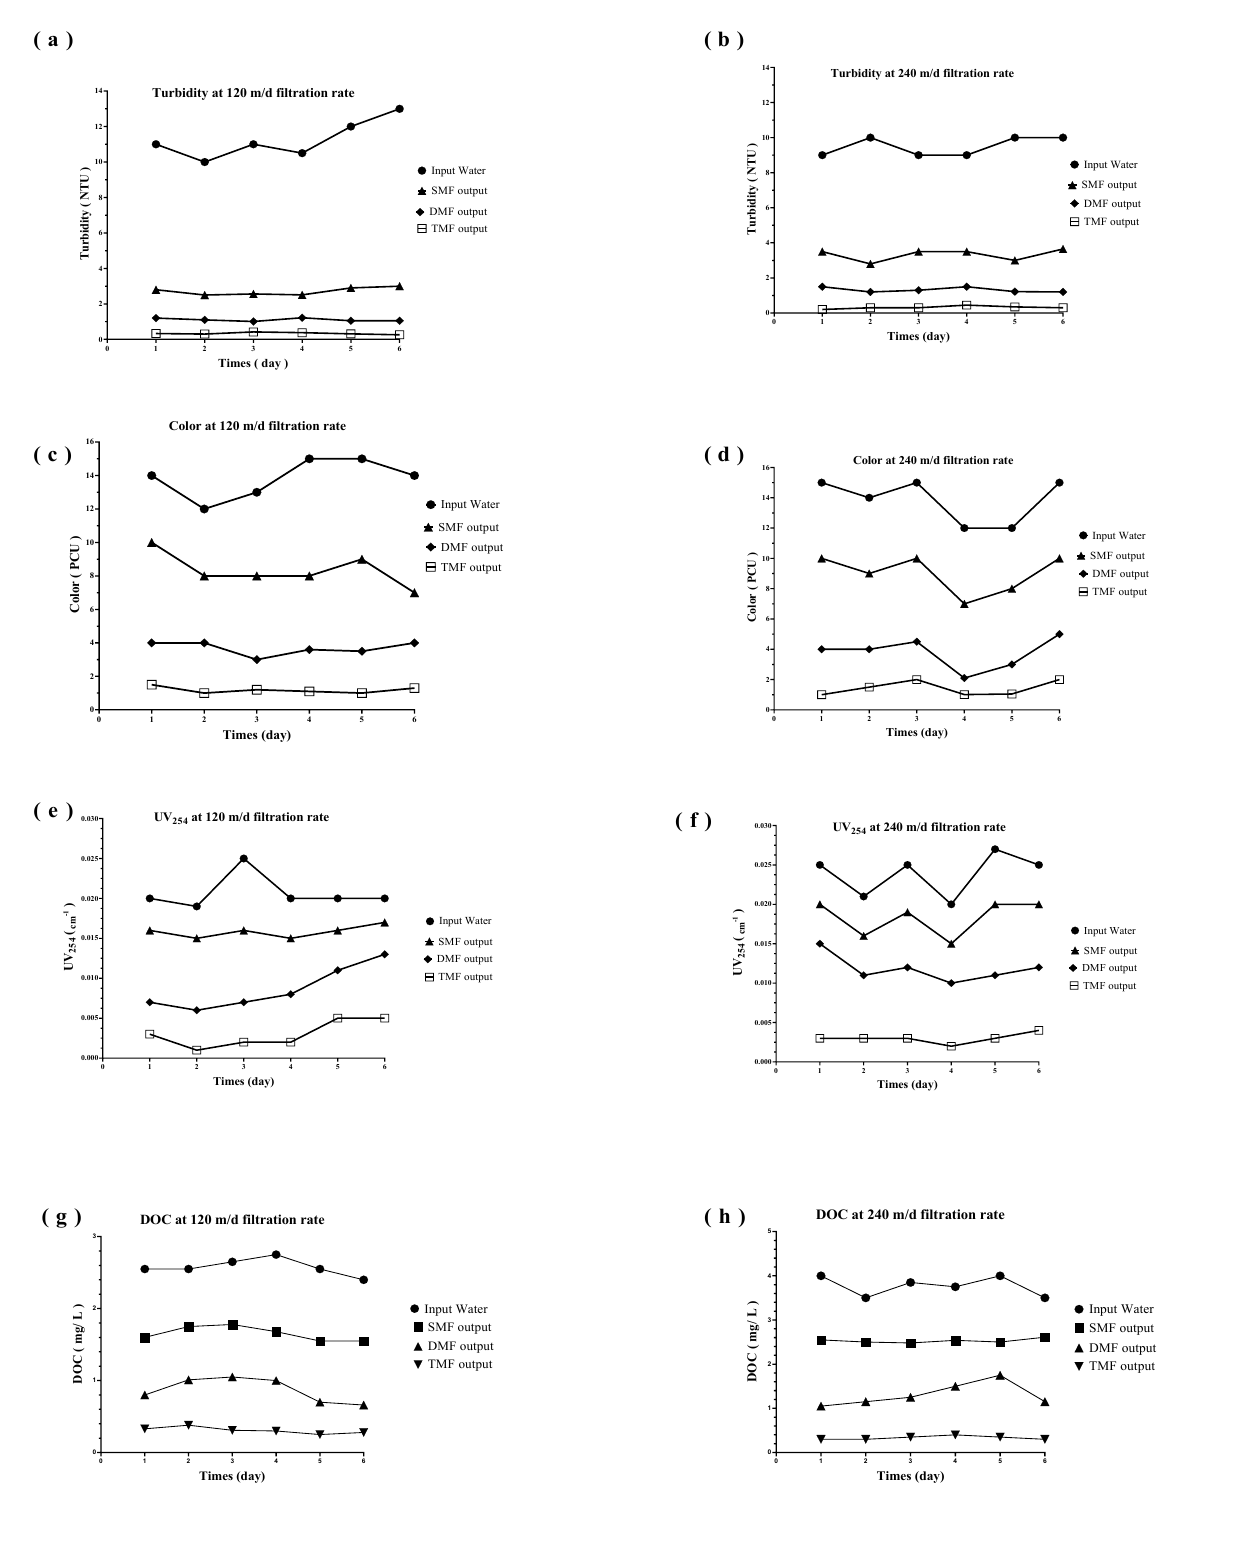
, and Dissolved Organic Carbon (DOC) removal in the single-, dual-, and triple- 254